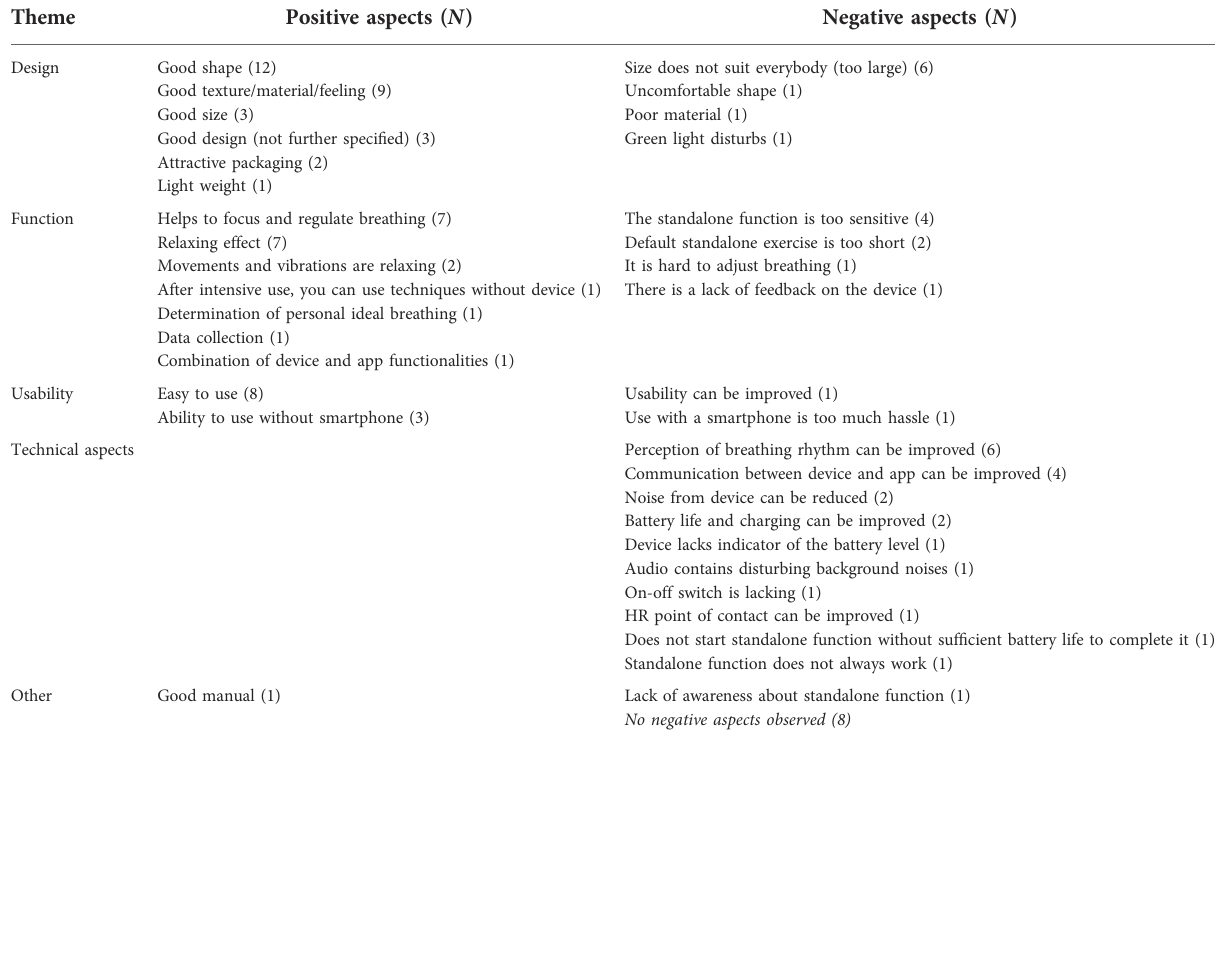
TABLE 3 Summary of positive aspects and important points of attention regarding the breath